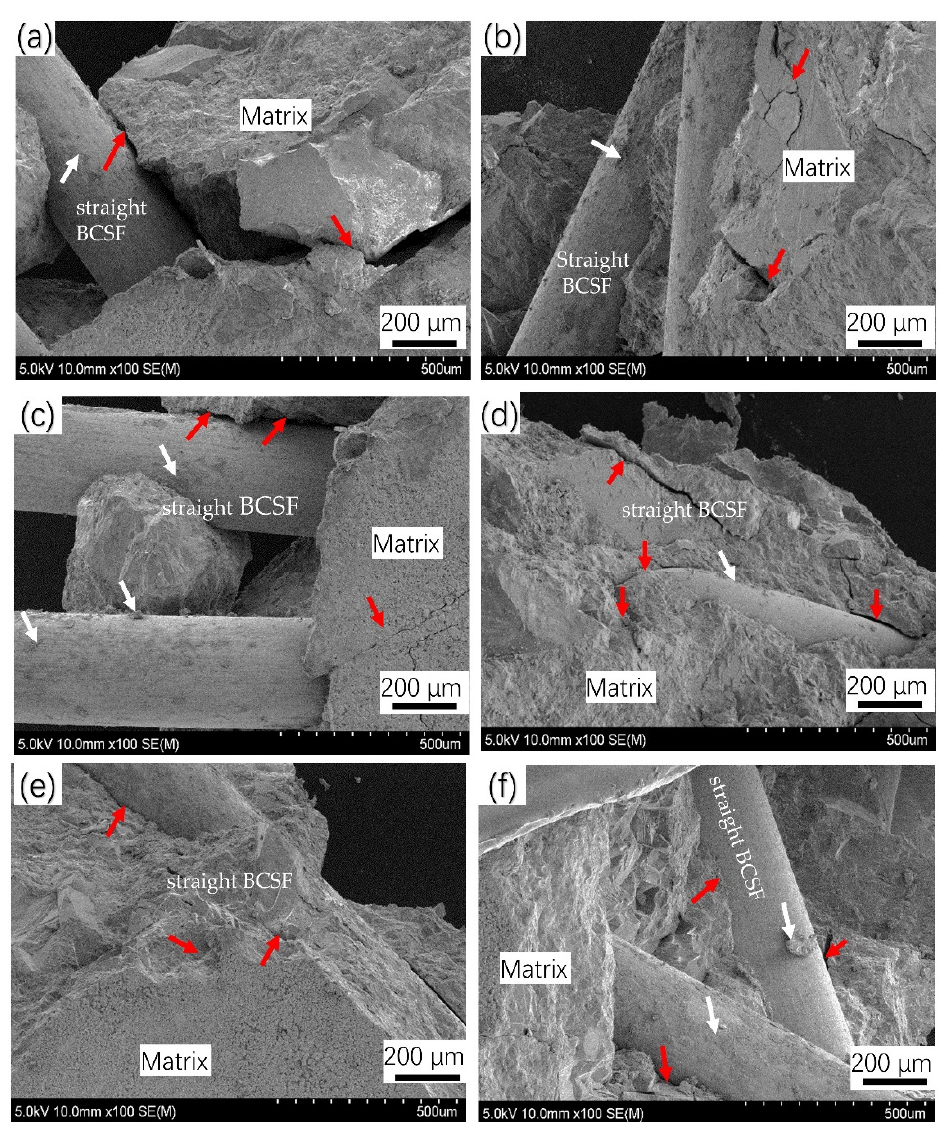
Figure 15. SEM imagines of the crack growth of straight BCSF-reinforced UHPC of different content cured for 28 days after flexural strength test: ( a ) 1%; ( b ) 2%; ( c ) 3%; ( d ) 4%; ( e ) 5%; ( f ) 6%.